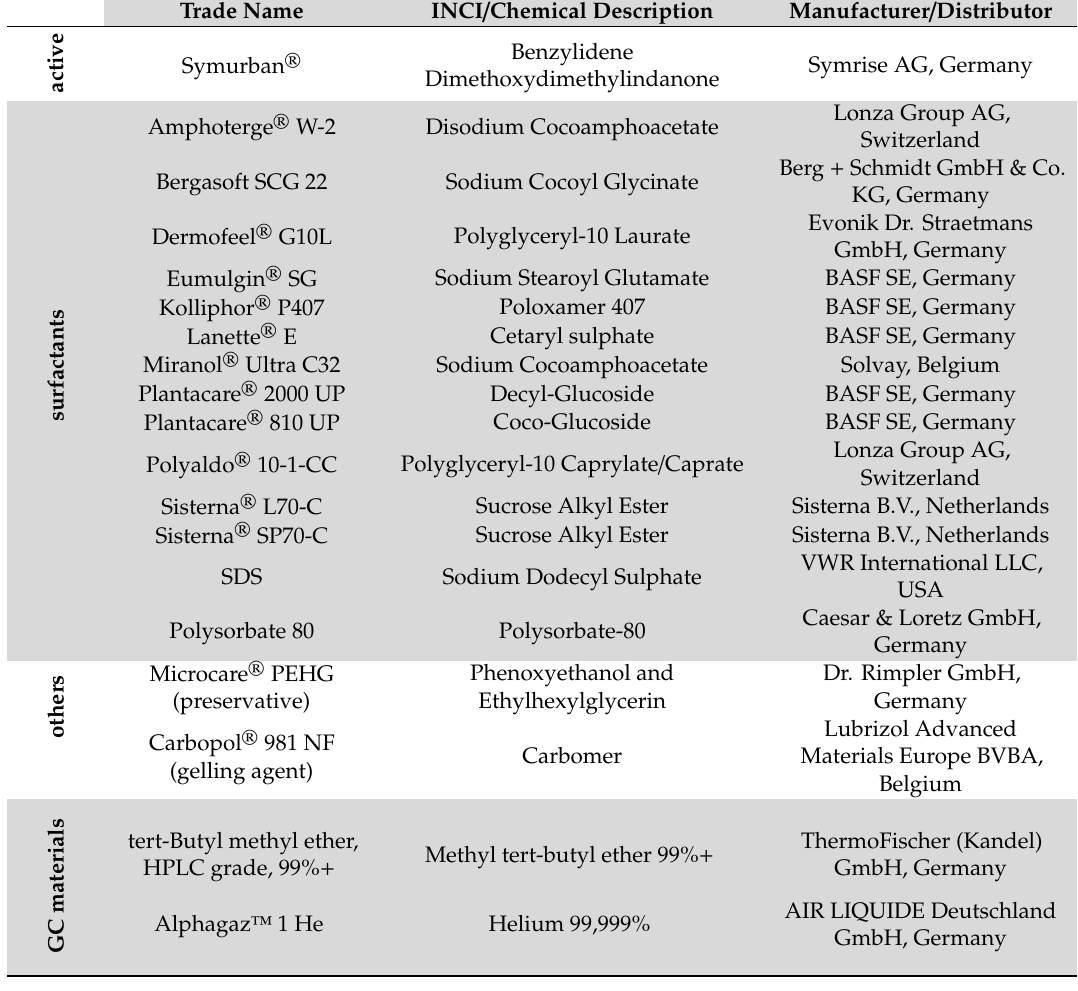
Table 1. Overview of all materials used in this